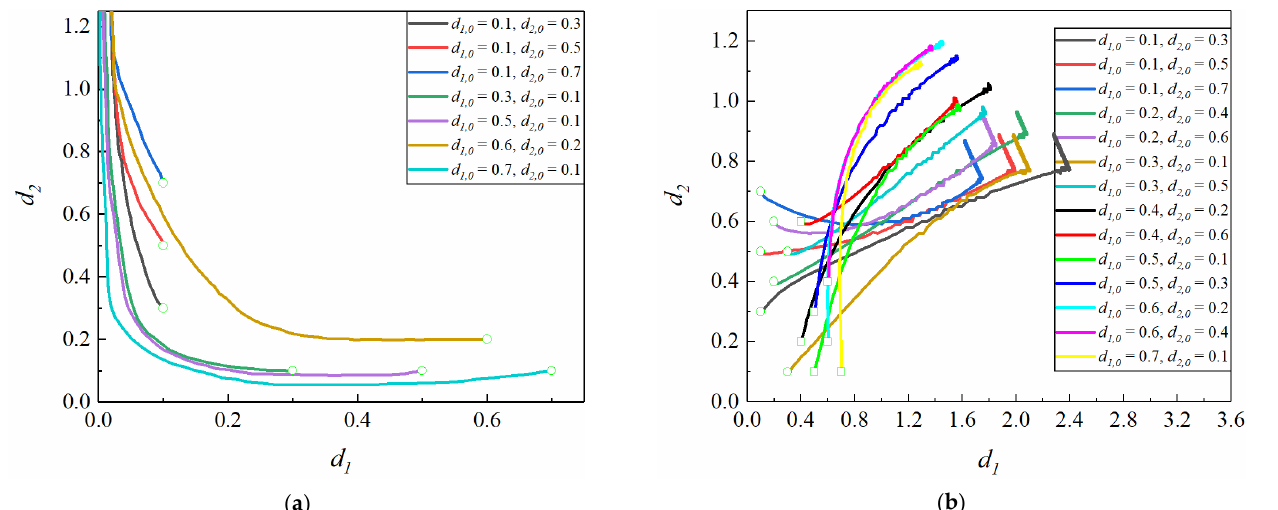
Figure 4. Variation of interparticle distances under more initial interparticle distances. ( Wi = 0.5, α = 0.1, η r = 0.3, ε = 0.3). ( a ) y 0 = 0; ( b ) y 0 = 0.2.